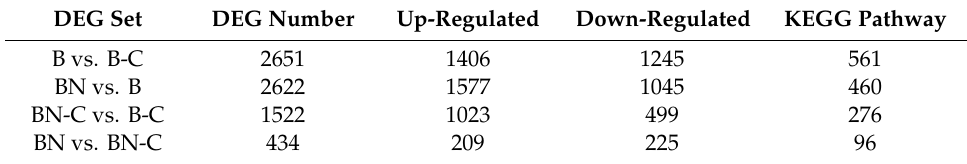
Table 4. Number of differentially expressed genes among samples.